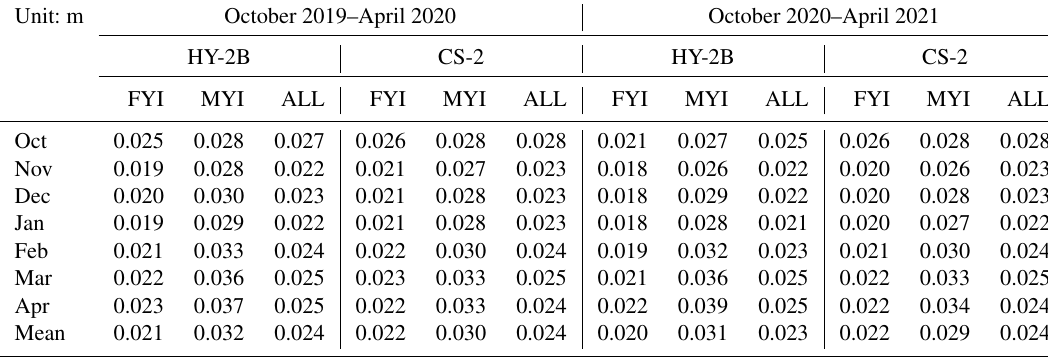
Table 9. Mean sea ice freeboard uncertainties of HY-2B and CryoSat-2 on FYI, MYI and total sea ice. Unit: